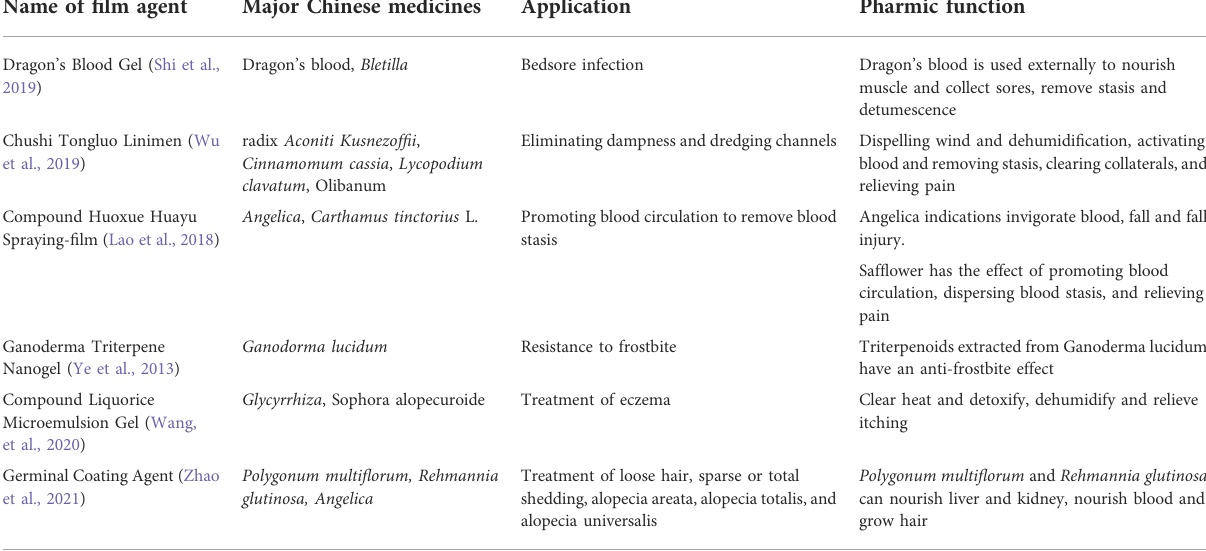
TABLE 4 Other clinical application and pharmacological mechanism of Chinese medicine fi lm